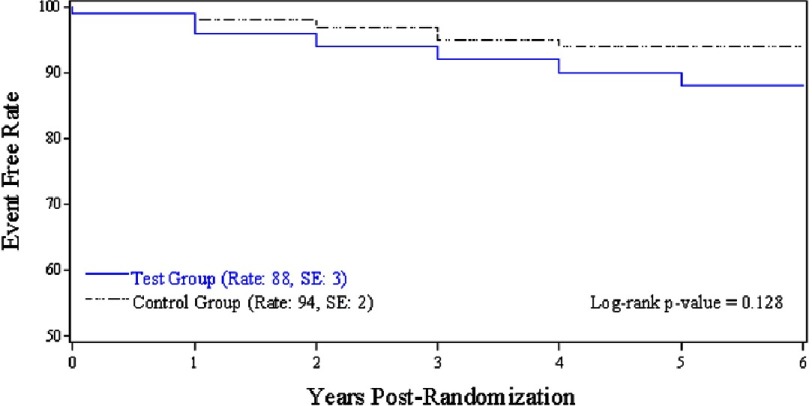
Five-year freedom from thromboembolic events in the test group (blue) versus the standard group (black) in the PROACT trial (from Puskas et al.8).